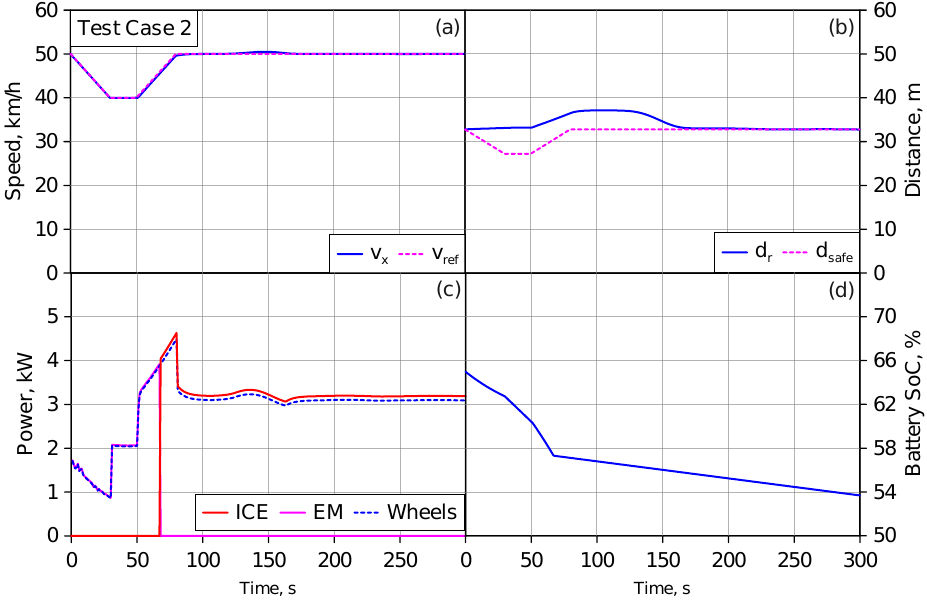
Figure 11. Test case 2: ( a ) speed (km/h); ( b ) relative distance (m); ( c ) ICE/EM/Wheels power (kW); ( d ) battery SoC